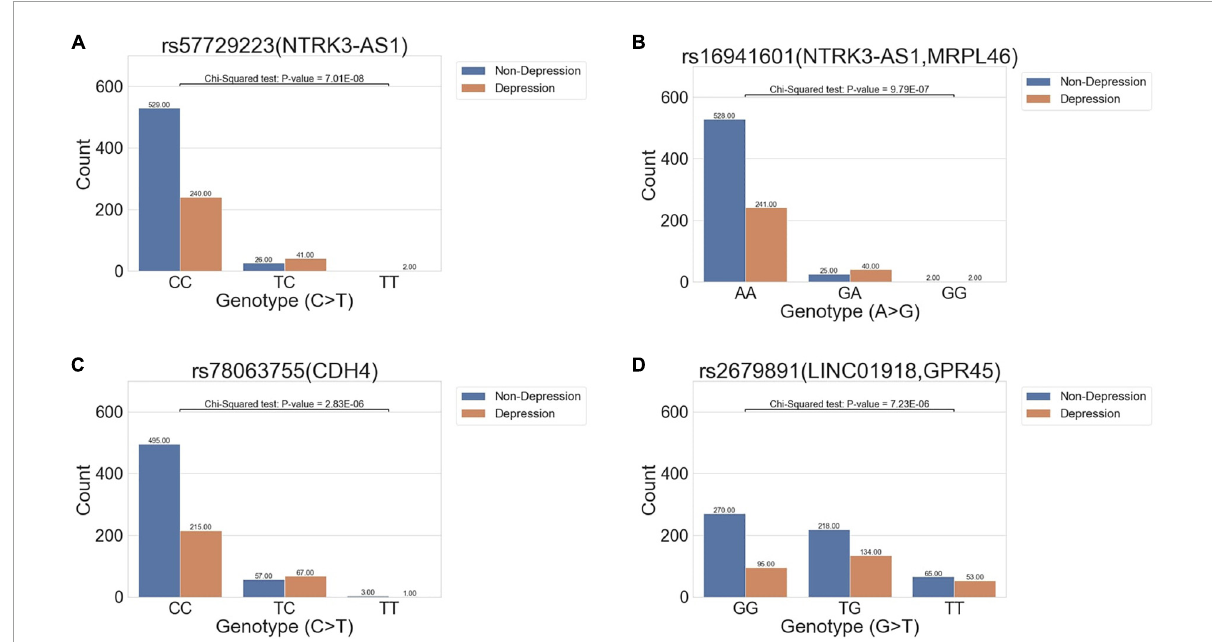
FIGURE2 Bar charts show the distribution of variant allele frequency of the variant in all migraine cohort between the non-depression and depression groups. The x-axis denotes the genotype of the variants, and the y-axis indicates the count of genotypes in the two phenotypes. The abundance of each condition in the genotypes is marked above each bar. Four variants (A) rs57729223 ( P = 7.01E-08, OR = 3.60), (B) rs16941601 ( P = 9.79E-07, OR = 3.14), (C) rs78063755 ( P = 2.83E-06, OR = 2.30), and (D) rs2679891 ( P = 7.23E-06, OR = 1.61) were found to be suggestively associated with depression in all migraine